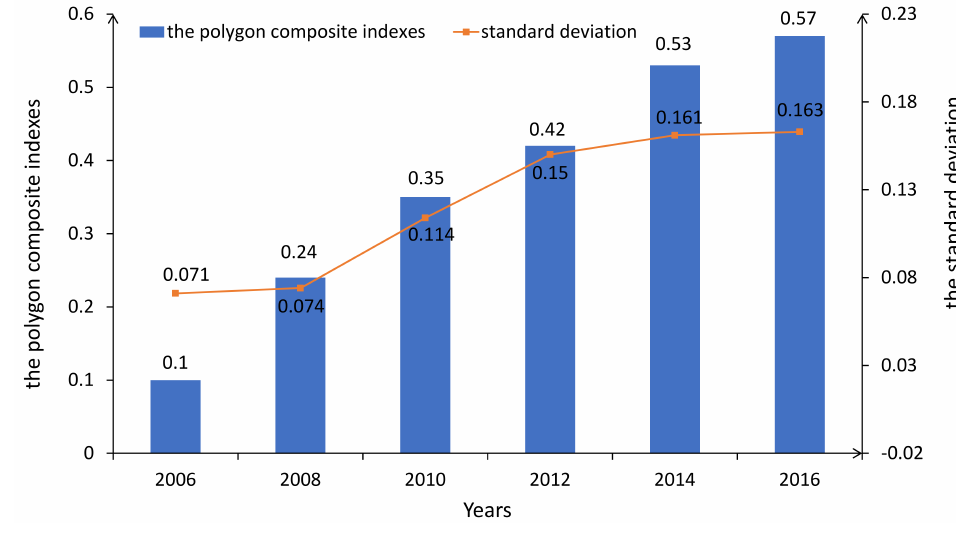
Figure 5. The standard deviation of